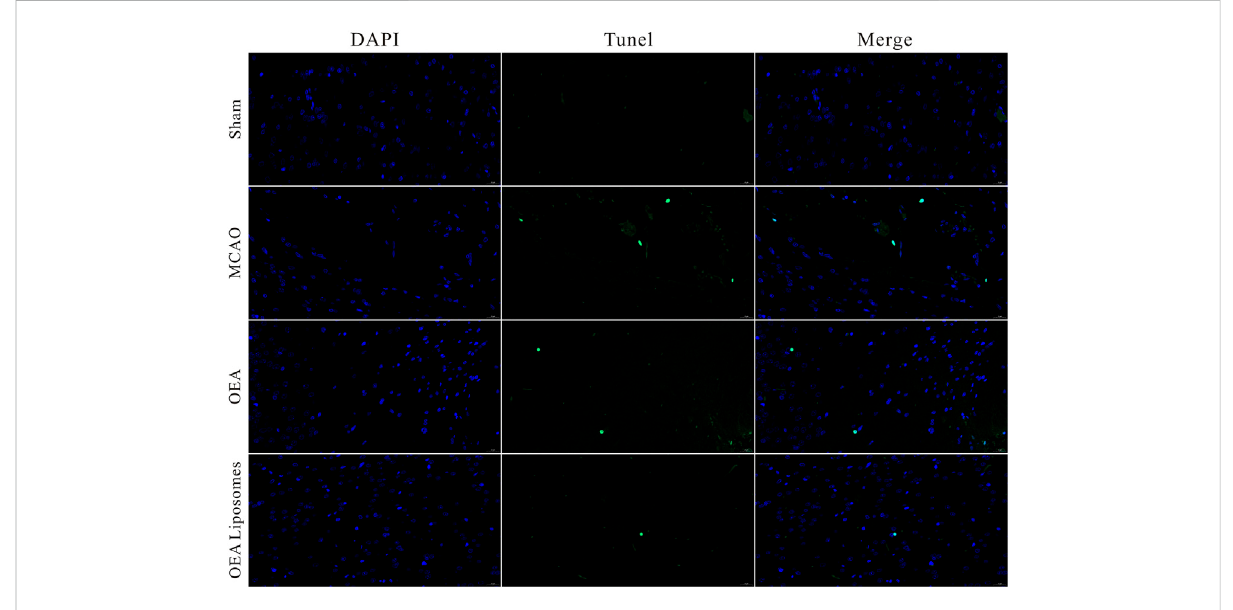
FIGURE 4 Representative pictures of the cortex stained with TUNEL.